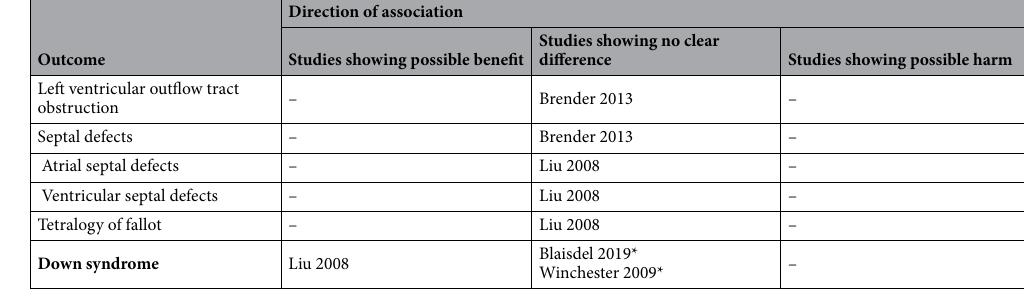
Table 3. Direction of findings. “–”: no study falls into this category. “*”: ecological, cross-sectional or prevalence